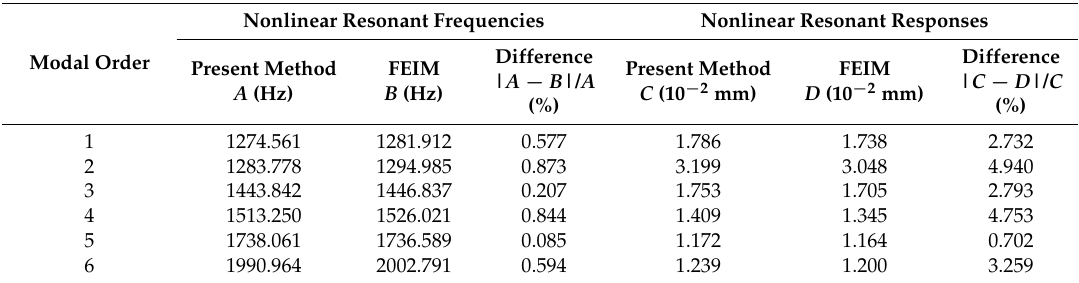
Table 4. Comparisons of the first 6 order nonlinear resonant frequencies and responses with the FEIM.